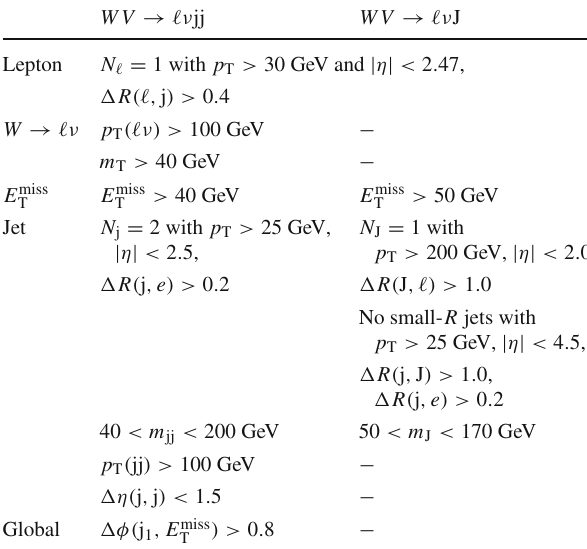
Table 2 Summary of the fiducial phase-space definitions. All the spec- ified selection criteria are applied at the particle level as specified in the text. The notations “j” and “J” refer to R = 0 . 4 and R = 1 . 0 jets, respectively, as explained in the